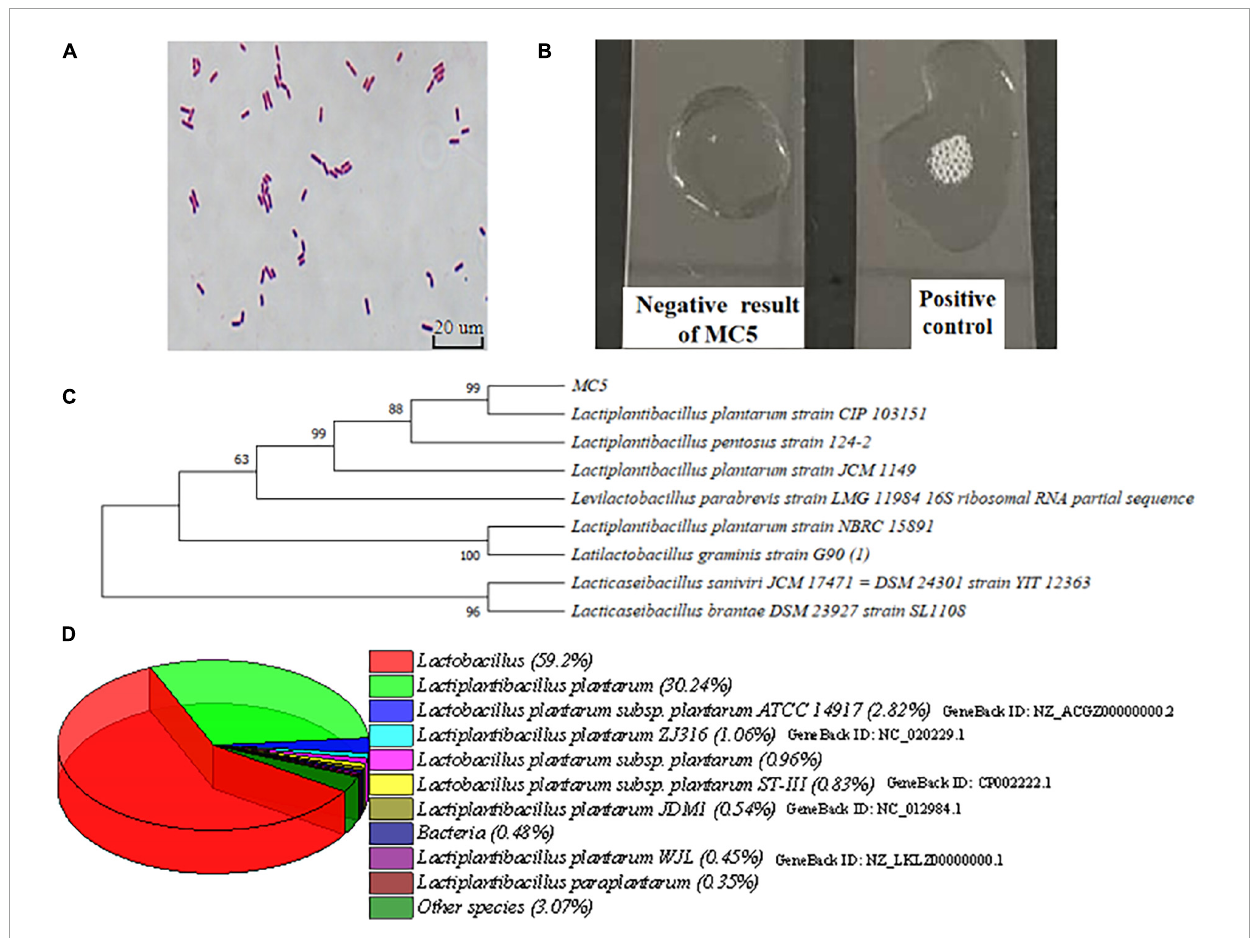
FIGURE2 (A) Morphology of strain MC5 by fluorescence microscopy; (B) catalase test of MC5; (C) phylogenetic tree of 16S rRNA gene sequences, and numbers at nodes represent represent homology; and (D) species identification of MC5 using annotations from the NR